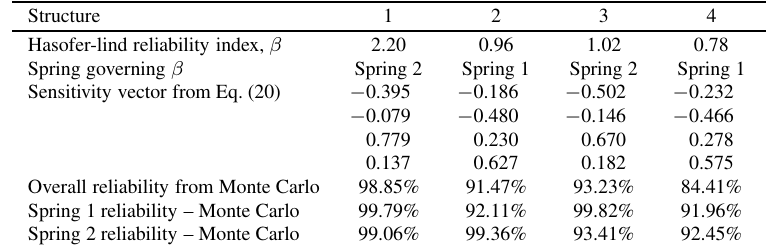
Table 2 Reliability indices, sensitivity vectors, and Monte Carlo reliabilities for two DOF structures Structure 1 Hasofer-lind reliability index,